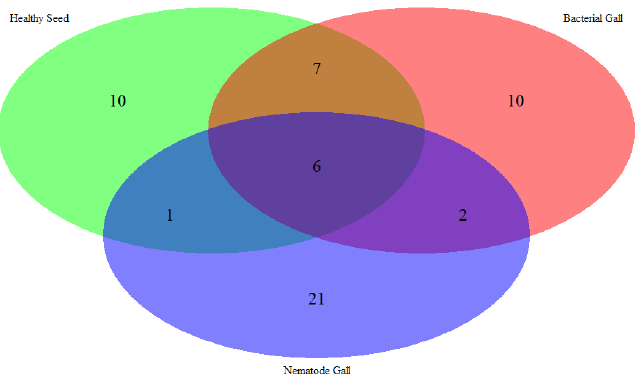
Figure 1. Metabolites obtained in nematode gall, bacterial gall and healthy seed of annual ryegrass. The points highlighted in red are significant compounds selected based on the p -value threshold (0.05), and green dots represent nonsignificant compounds.